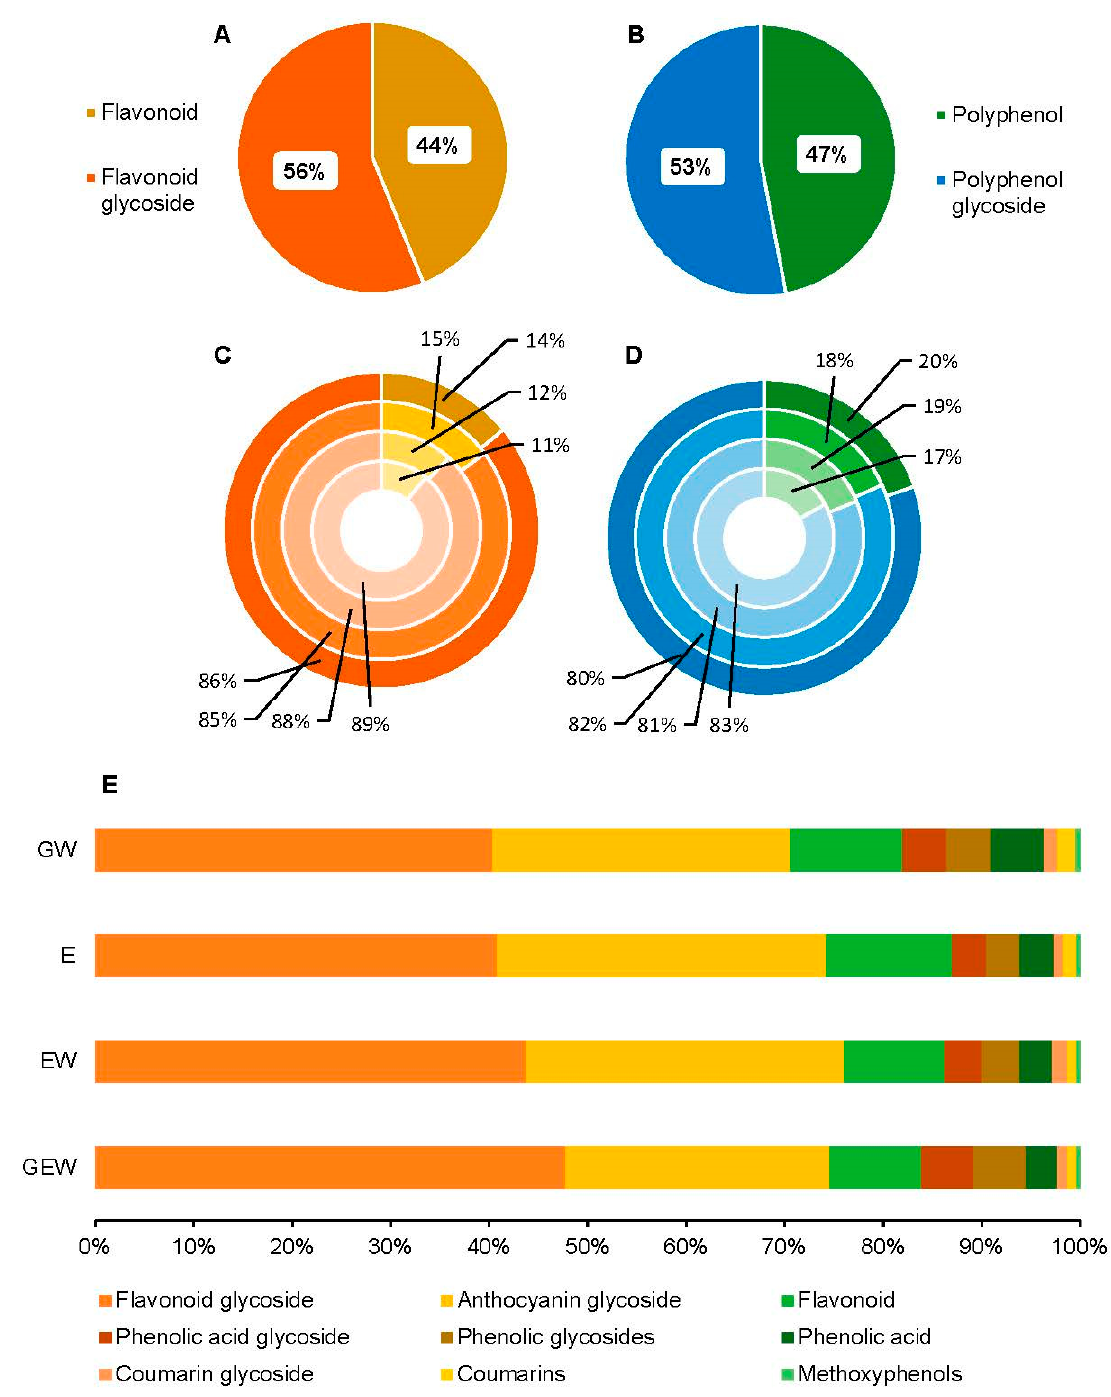
Figure 6. ( A – E ) Ontology breakdown of aglycone and glycosidic forms of the polyphenols ( n = 284) in QGP extracts. Top pie charts show the ratio of flavonoid: flavonoid glycoside ( A ) and polyphenol: polyphenol glycosides ( B ) in QGP. Stacked pie charts (middle) shown the relative abundance of flavonoid ( C ) and polyphenol aglycones and glycosides ( D ) across the four extraction solvents. The extractions solvents are in order from inner to outer circle; GEW, EW, E, GW. The breakdown of the nine major phenolic classes found in QGP are shown in the horizontal bar graph (bottom) ( E ).